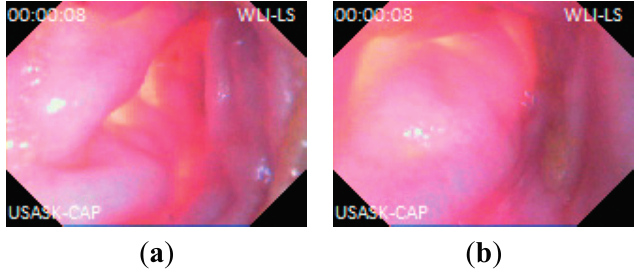
Figure 14. Captured lossless WLI images from live pig’s intestine: ( a ) CR = 72.43%; ( b ) CR = 74.09%.